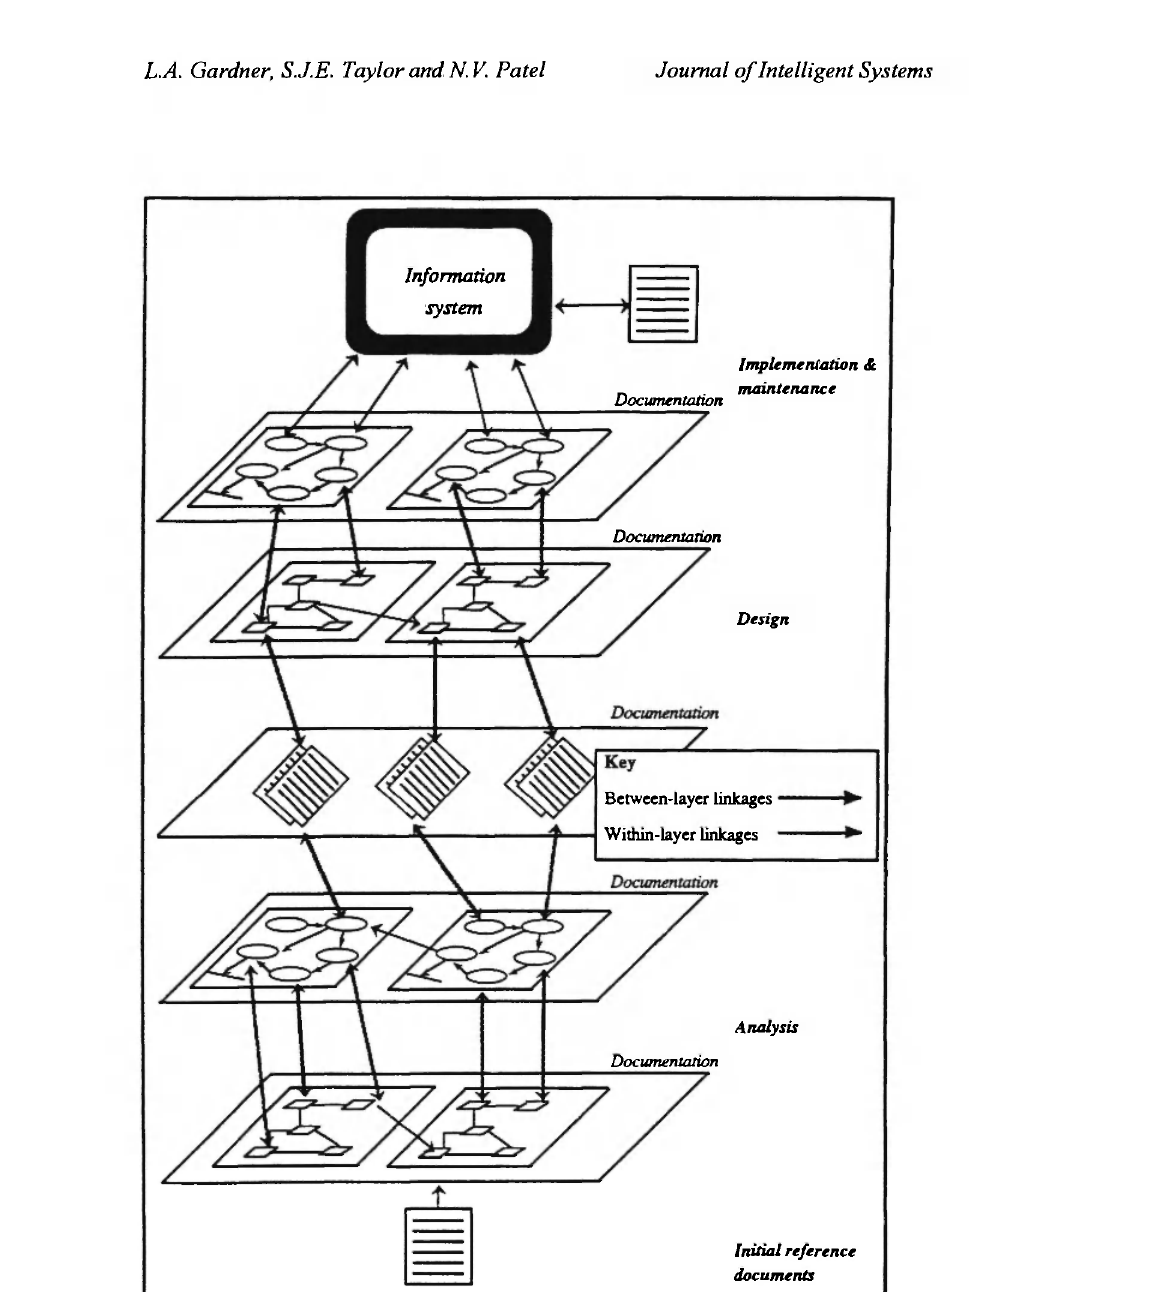
Fig. 2: The FIELD system